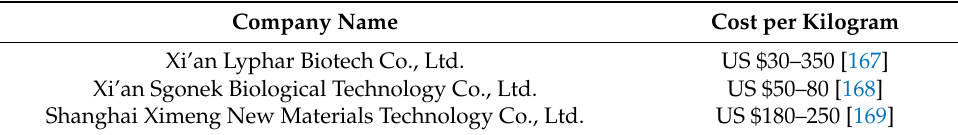
Table 9. Cost of Hydroxyapatite in Various